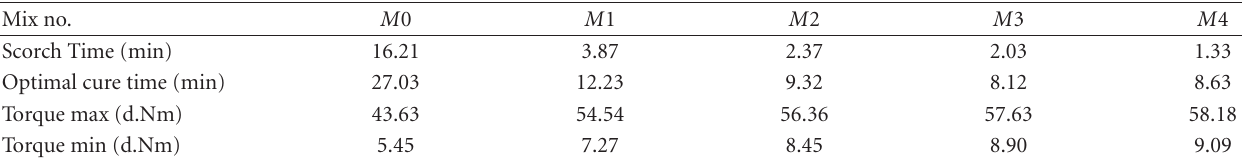
Table 3: Cure characteristics of mixes at 150 ◦ C.